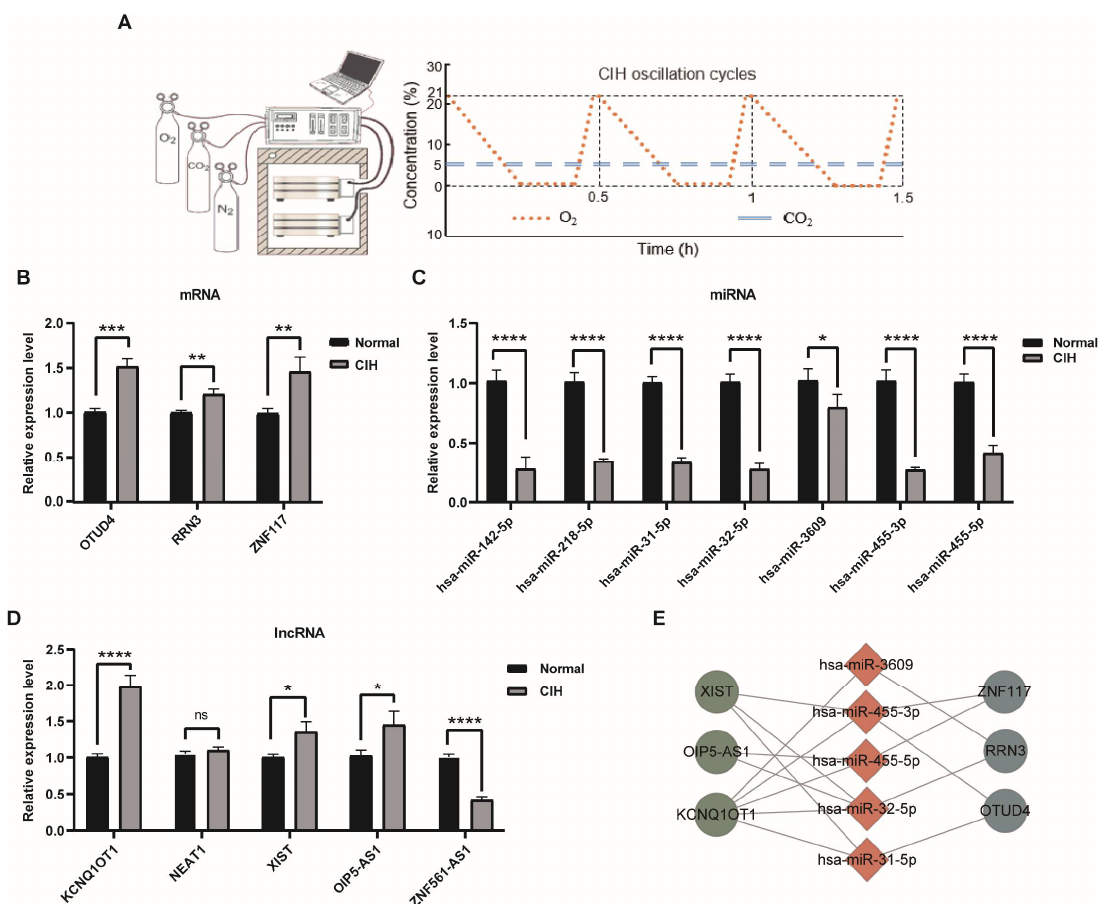
Figure 8. Validation of the hub ceRNA networks. ( A ) The schematic of the CIH condition. ( B ) Expression of the mRNAs in the hub ceRNA networks. ( C ) Expression of the miRNAs in the hub ceRNA networks. ( D ) Expression of the lncRNAs in the hub ceRNA networks. ( E ) The validated ceRNA networks. Unpaired Student’s t-test. * p < 0.05; ** p < 0.01; *** p < 0.001; **** p < 0.0001.